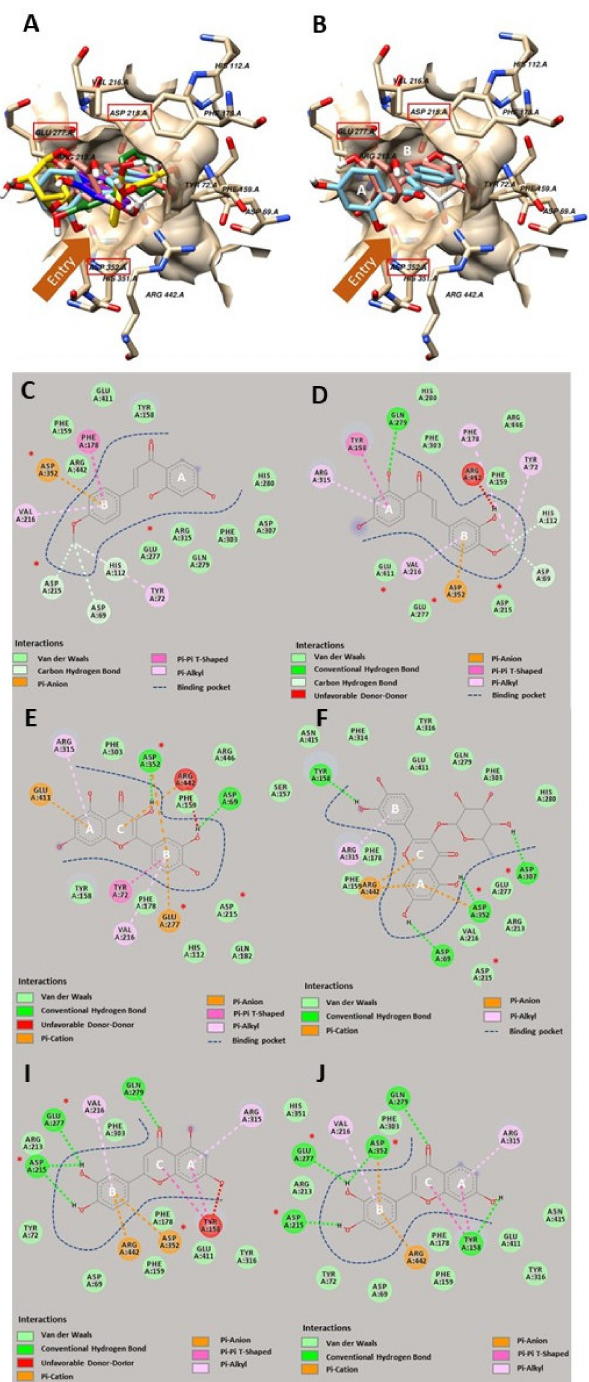
Figure 2. The molecular interaction between amino acids in the active site of glucosidase (Ivory) and glucose as a native ligand (White) and isolated flavonoids, luteolin (Blue), 5-deoxyluteolin (Pink), quercetin (Green), quercitrin (Yellow), chalcones, 3,2’,4’-trihydroxy-4-methoxychalcone (Red) and 4-methyl ether isoliquiritigenin (Cyan) from Bauhinia pulla ( A ). Structural alignment of 3,2’,4’- trihydroxy-4-methoxychalcone (Red) and 4-methyl ether isoliquiritigenin (Cyan) in the active site of glucosidase (Ivory) ( B ). 2D interaction diagram of 4-methyl ether isoliquiritigenin-glucosidase com- plex ( C ), 3,2’,4’-trihydroxy-4-methoxychalcone-glucosidase complex ( D ), quercetin-glucosidase com- plex ( E ), quercitrin-glucosidase complex ( F ), luteolin-glucosidase complex ( I ), and 5-deoxyluteolin- glucosidase complex ( J ). Catalytic residues in the active site indicated by red boxes and asterisks. A, B and C indicate the ring system in both flavonoids and